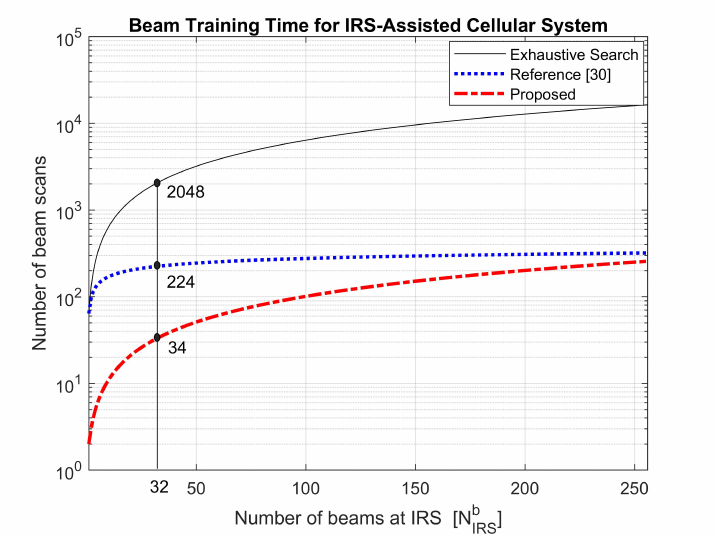
Figure 8. Number of beam scans required for IRS-assisted cellular